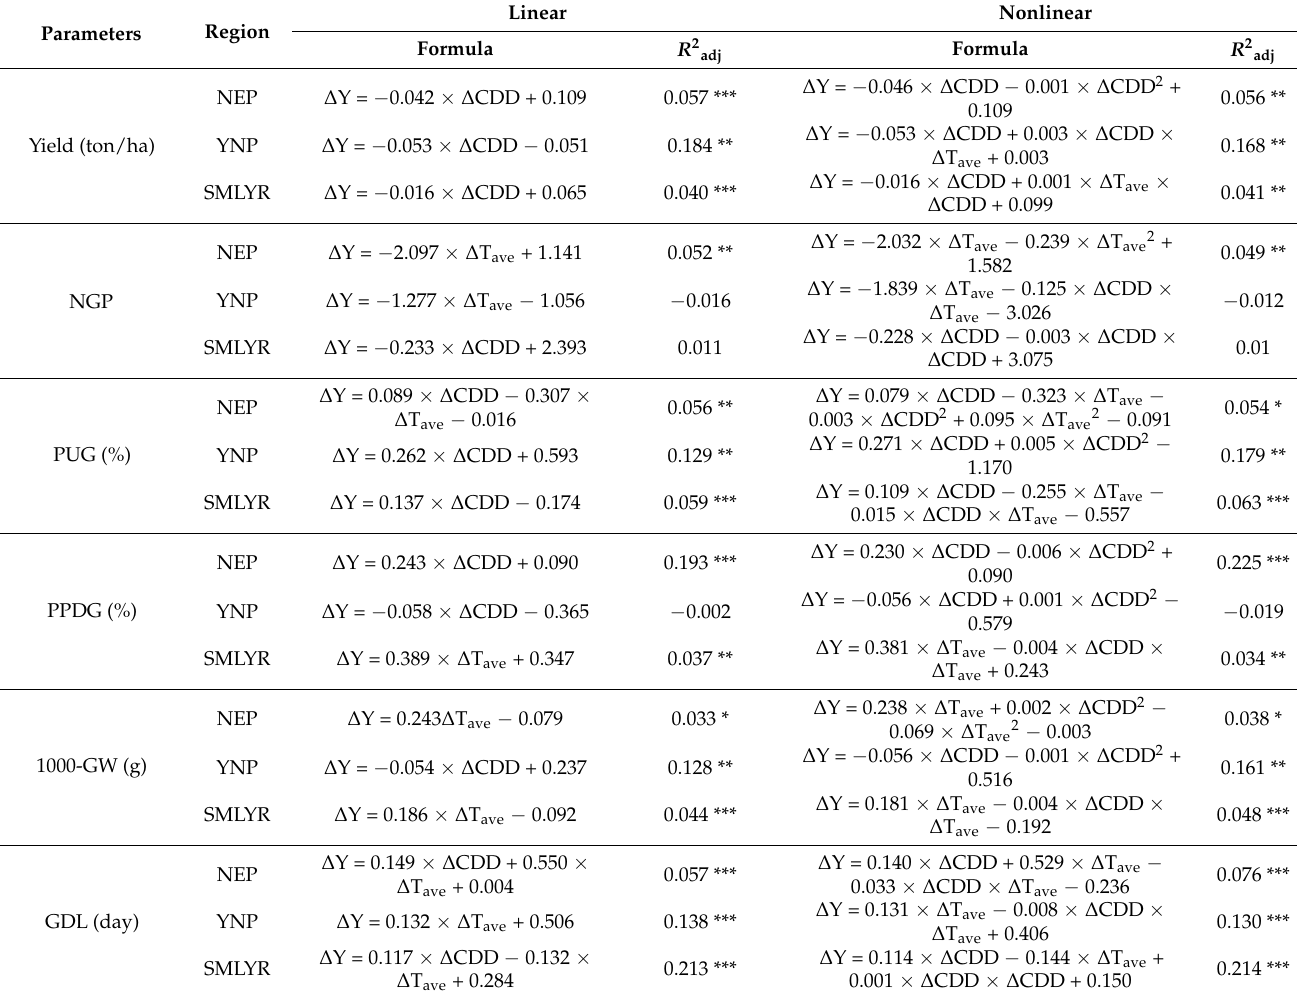
Table 2. The selected best multivariate linear and nonlinear equations for yield and related variables as a function of temperature indices during heading and